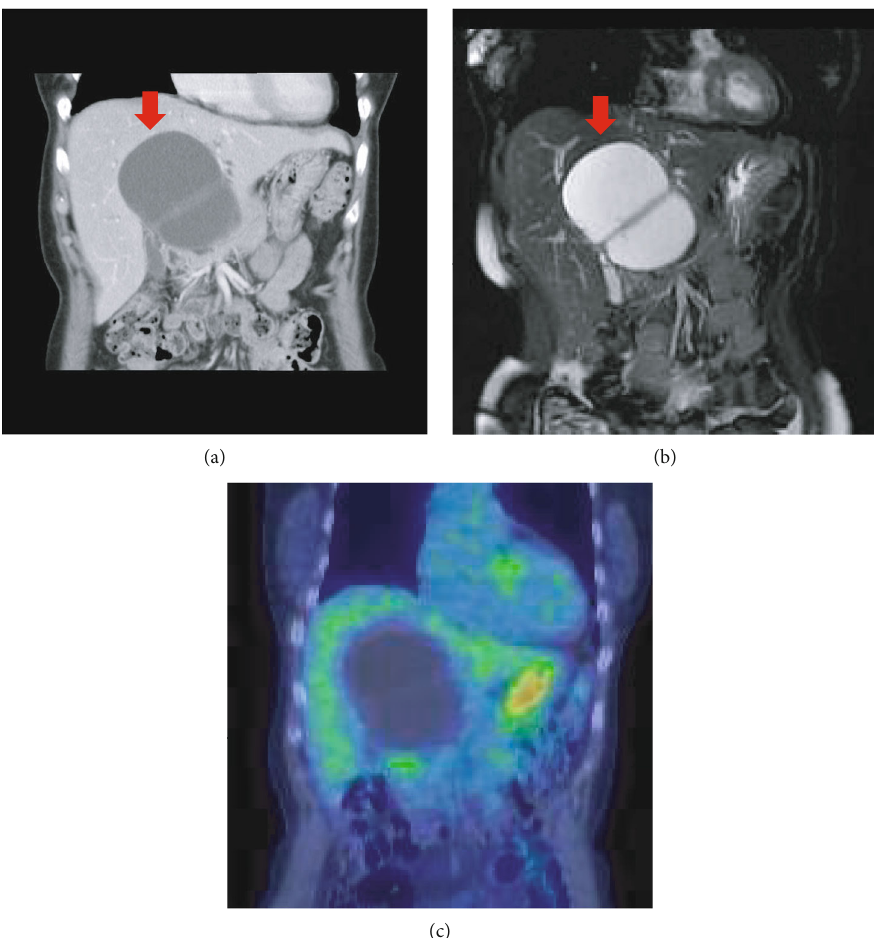
Figure 1: (a) Enhanced computed tomography and (b) T2-weighted magnetic resonance imaging show cystic lesions with septations arising from macrolobulations in the medial segment of the liver (red arrows). Uptake of fl uorodeoxyglucose in the cystic lesions was not observed on positron emission tomography